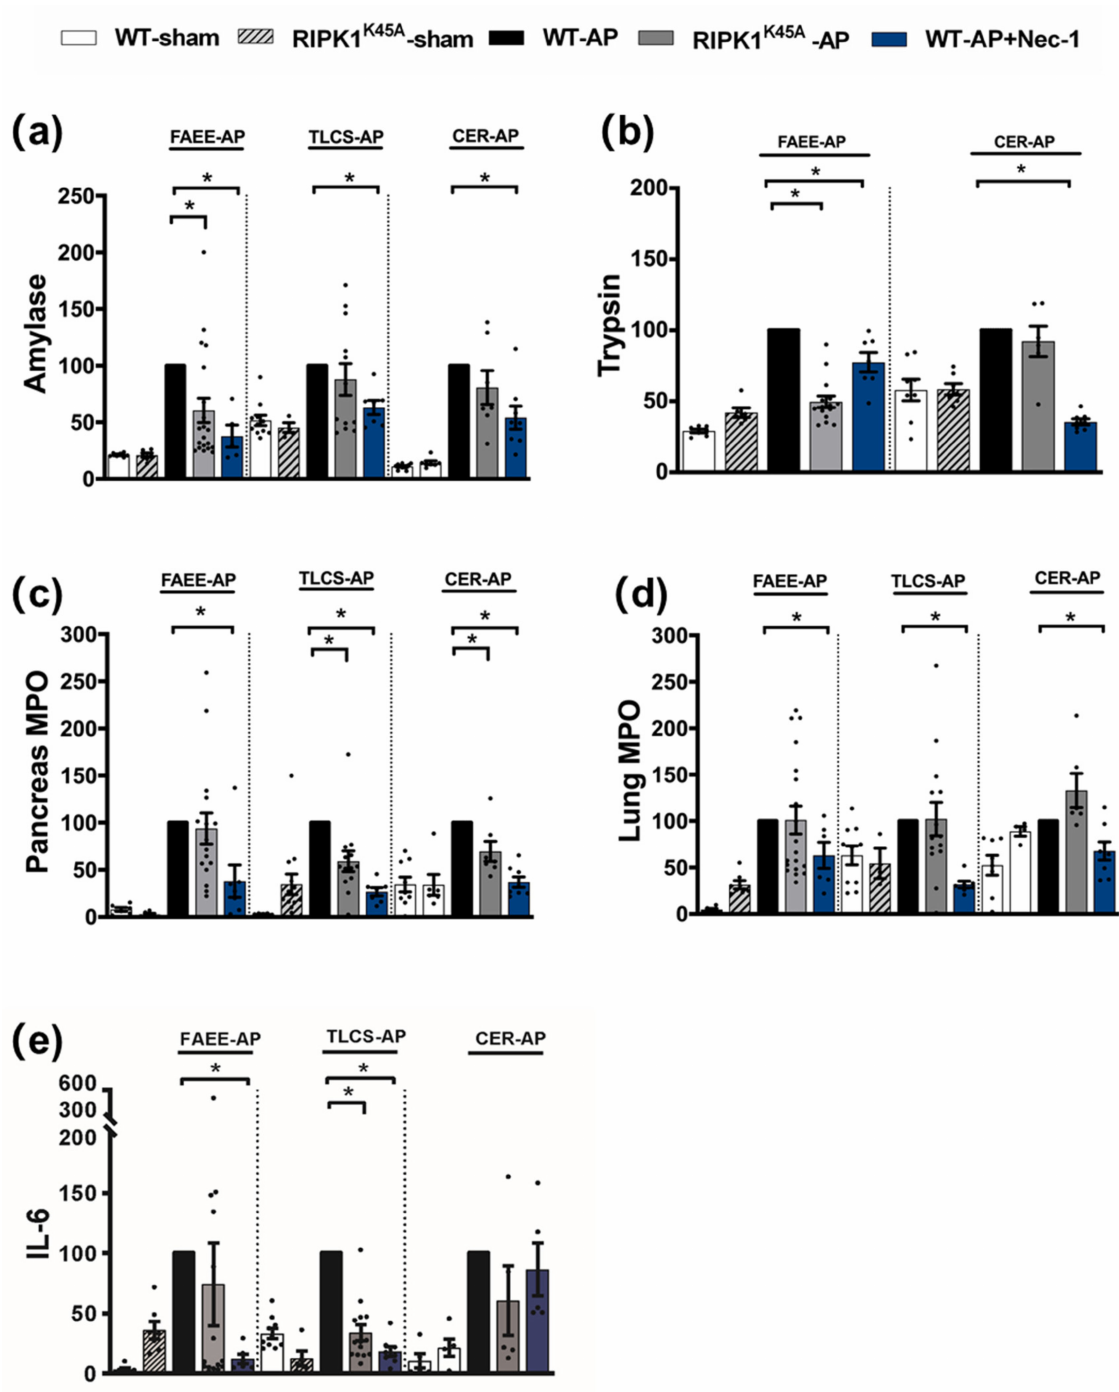
Figure 2. Comparison of biochemical changes in FAEE-AP, TLCS-AP and CER-AP in RIPK1 K45A and WT mice. Changes in the levels of ( a ) amylase, ( b ) trypsin, ( c ) pancreatic myeloperoxidase (MPO), ( d ) lung MPO and ( e ) interleukin-6 (IL-6) are shown in three AP models. Each dot represents a mouse. Responses were normalized to control changes after AP induction in WT and are expressed as the mean ± SEM ( ≥ 5 mice/group). Significant differences between RIPK1 K45A or Nec-1 treatment groups from control are shown as * p <